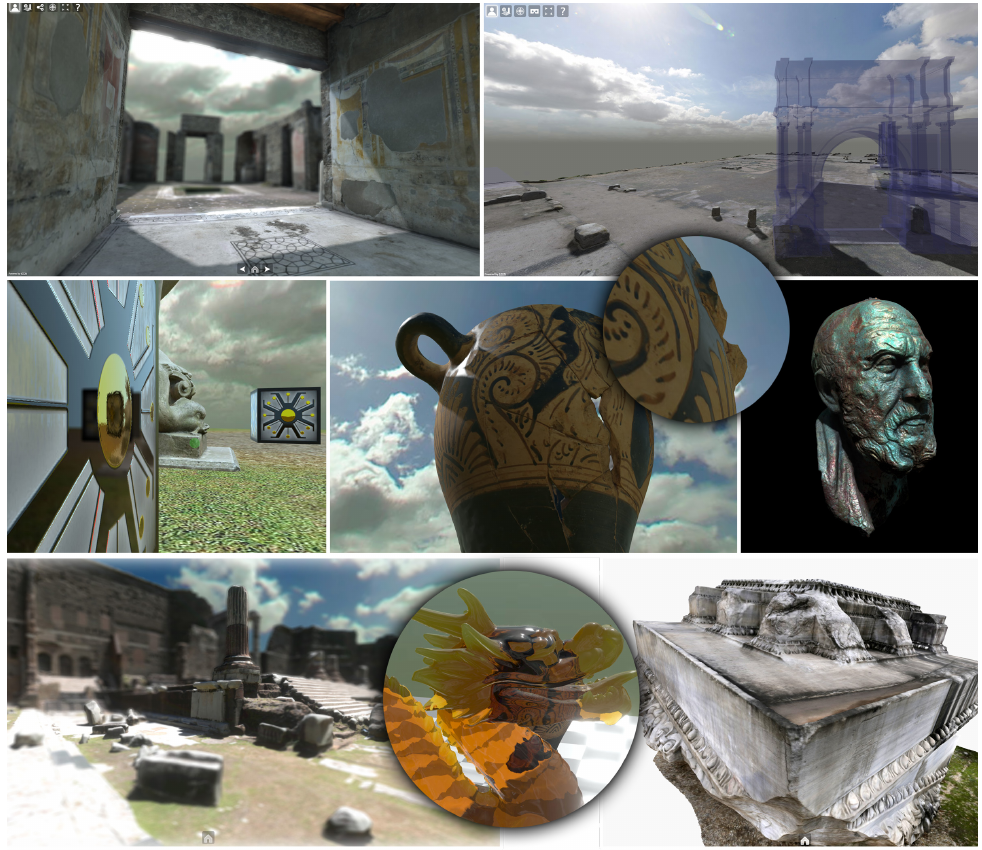
Figure 8. A few captures from interactive 3D scenes in ATON. Top row : real-time shadows and advanced effects (bloom, ambient occlusion); Middle row : multiple light-probes system and PBR ma- terials; Bottom row : depth-of-field effects, real-time volumetric refraction and absorption (Khronos glTF extension) and multi-resolution dataset (Cesium 3D